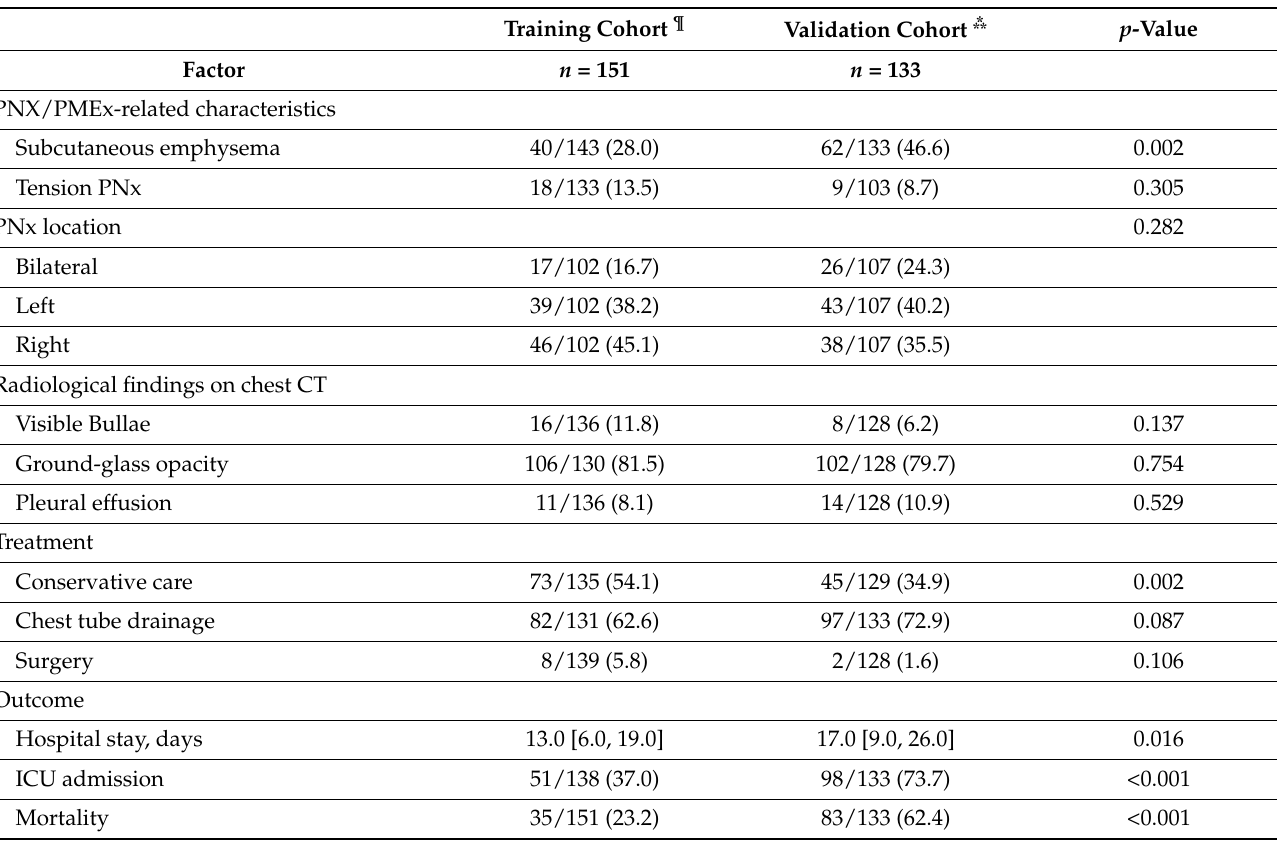
Table 4. Clinical characteristics and outcomes of patients: comparison of the training and validation cohorts.